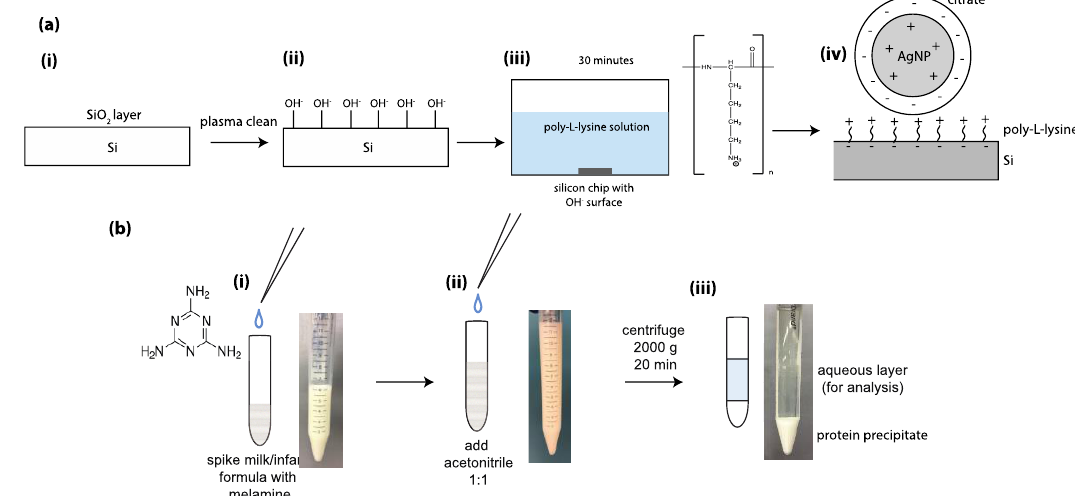
Figure 4. Preparation of the sensing chip and the analyte solutions for detection in milk and infant formula. ( a ) The procedure for silicon surface modification with poly-L-lysine, to anchor the dendrites. (i) The starting silicon surface with a thermally grown oxide layer is plasma cleaned for 3 min, (ii) leaving negatively charged hydroxyl groups at the surface. (iii) The chip is then soaked in poly-L-lysine. (iv) The nanoparticles, coated with a layer of citrate for stabilization in solution, adhere to the poly-L-lysine coated surface. ( b ) The sample processing method applied for milk and infant formula; (i) Spiked solutions of milk/infant formula were thoroughly mixed with a vortex mixer. (ii) Acetonitrile was added to the spiked milk, followed by vortex mixing and centrifugation. (iii) The supernatant (aqueous layer) was removed for analysis, and the protein pellet was discarded.